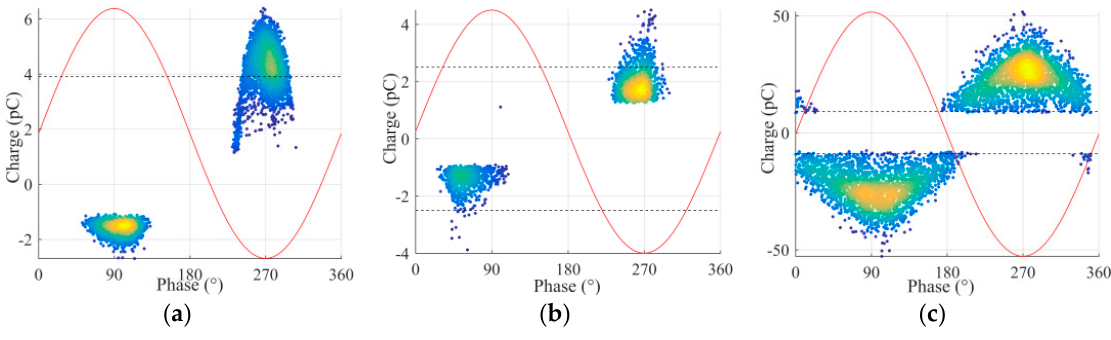
Figure 11. PRPD patterns, ( a ) corona, ( b ) surface, ( c ) free moving particle.